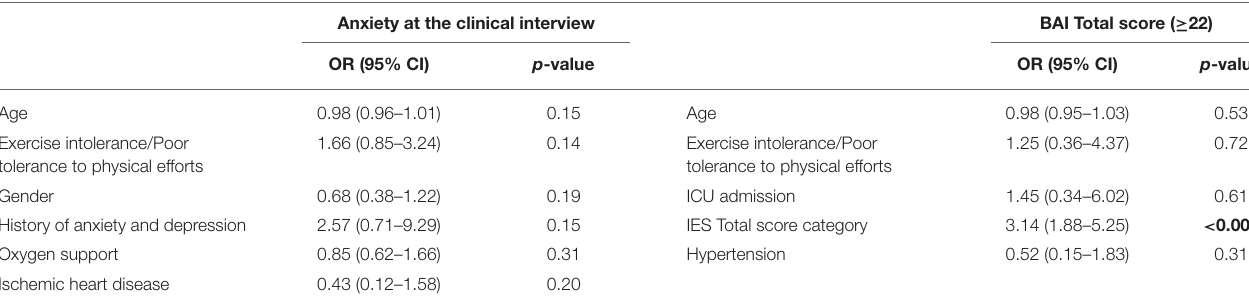
TABLE 3 | Logistic regression model for anxiety as assessed at the psychiatric interview and with the BAI. Anxiety at the clinical